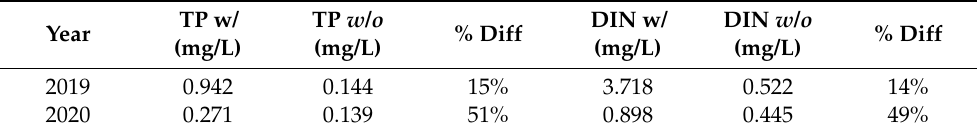
Table 3. Comparison of the mean TP and DIN concentrations with and without outliers removed for the years 2019 and 2020. For part of 2020, screens were installed on the sample buckets.